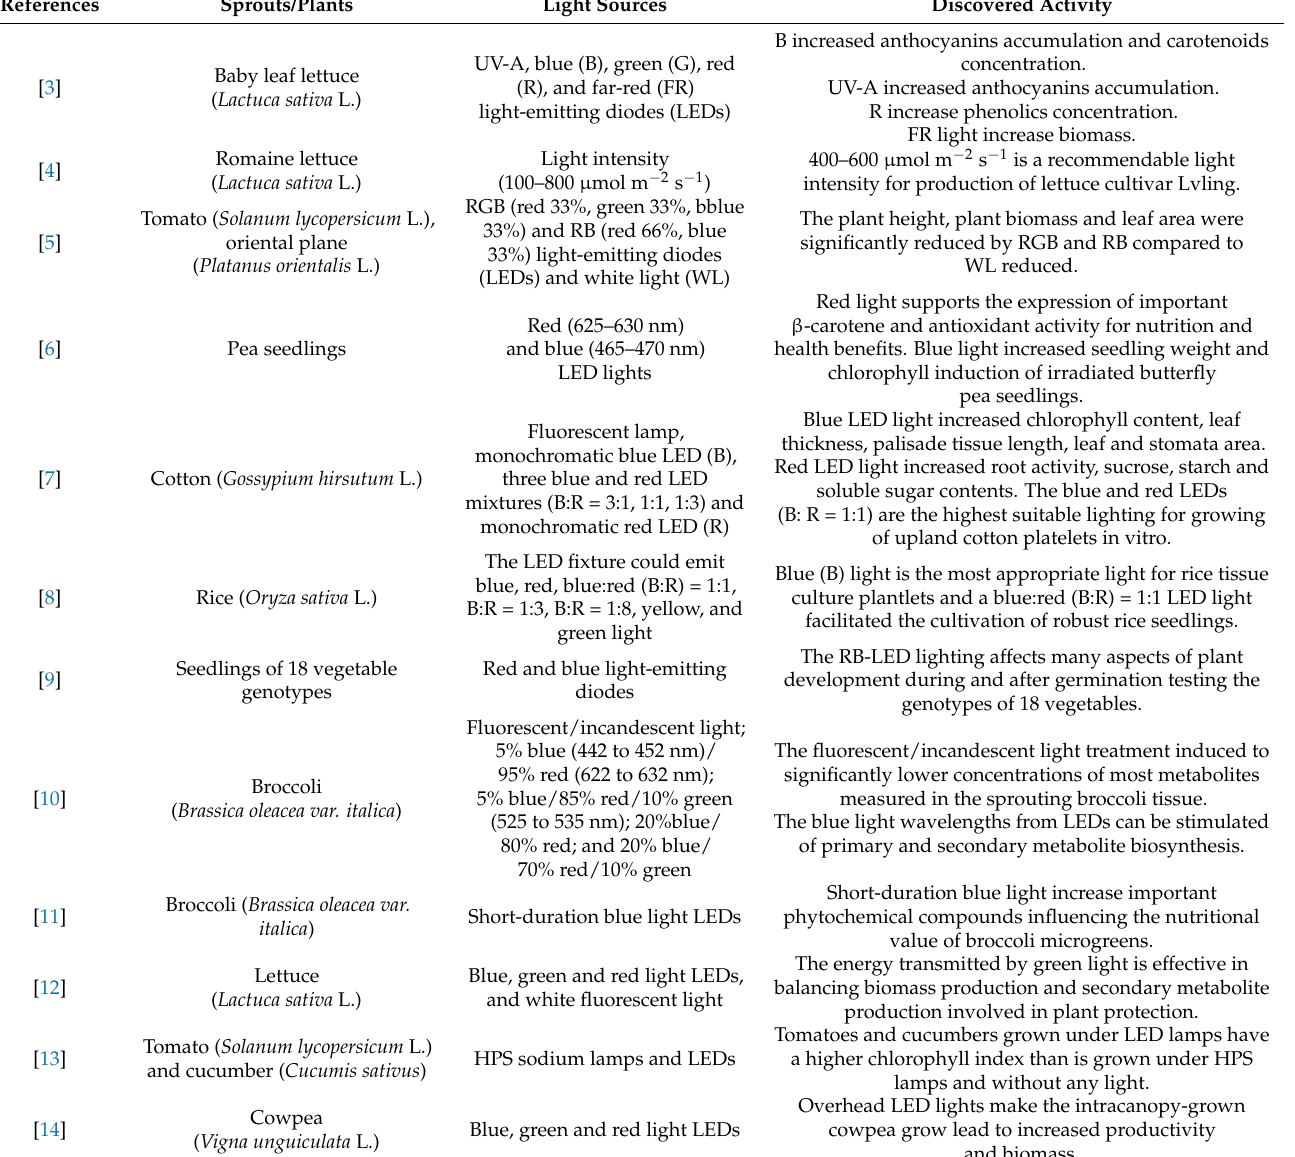
Table 5. Effect of light and light-emitting diodes on growth of sprout and